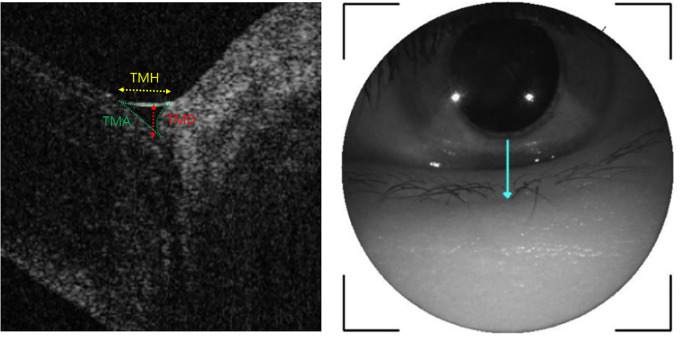
Measurements of TMH, TMD, and TMA.TMH (yellow line) was measured as the distance from the cornea–meniscus junction to the lower eyelid–meniscus junction. TMD (red line) was measured as the vertical distance from the interface of the cornea with the lower eyelid to the yellow line. TMA (area bounded by green lines) was calculated proportionally using ImageJ software from the OCT measured TMH value, TMA was calculated by the square of the ratio multiplied by the ImageJ-based TMA.